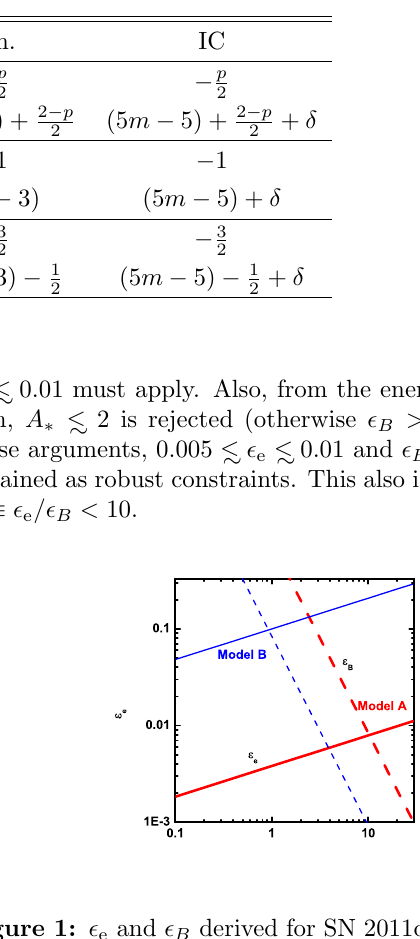
Figure 1: (cid:15) e and (cid:15) B derived for SN 2011dh, as a func- tion of A ∗ (Maeda,